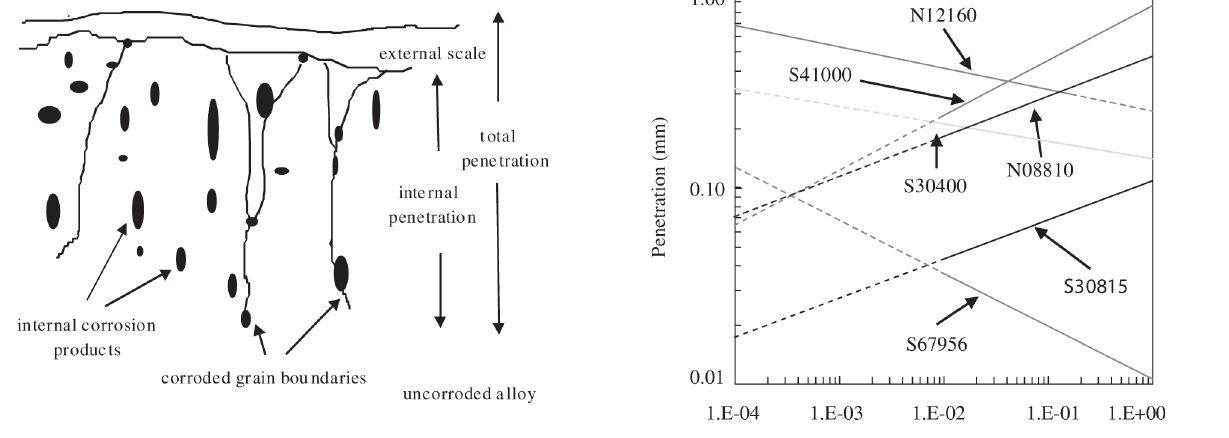
Figure 1. Schematic View of Total Penetration Measurement for a Typical Corrosion Product Morphology